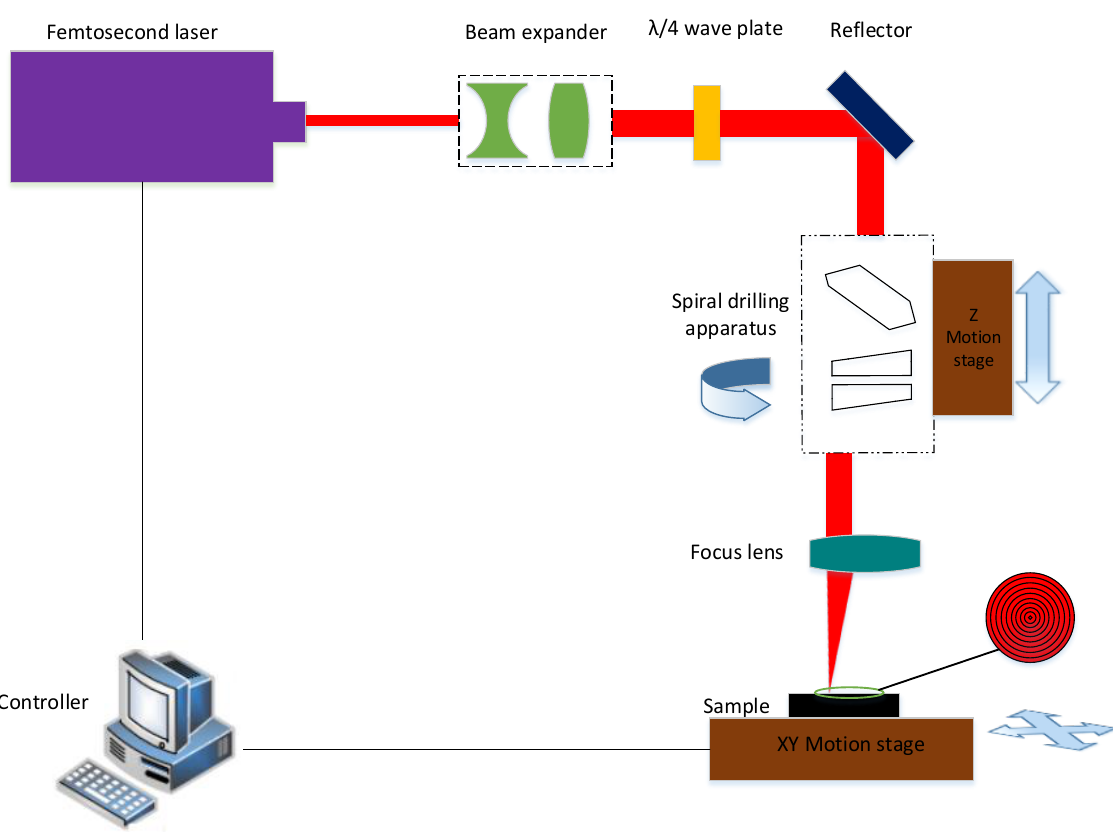
Figure 1. Schematic diagram of the femtosecond laser spiral drilling apparatus. Table 1. Parameters of the femtosecond